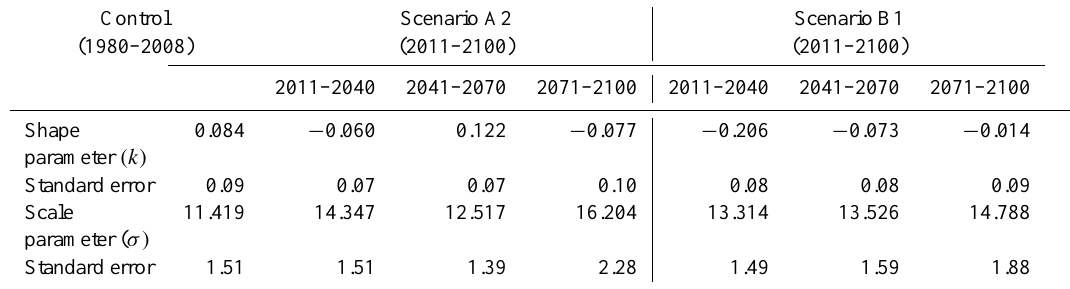
Table 5. Parameters of the GP distribution estimates for the Alt Llobregat sub-basin, together with its standard errors.